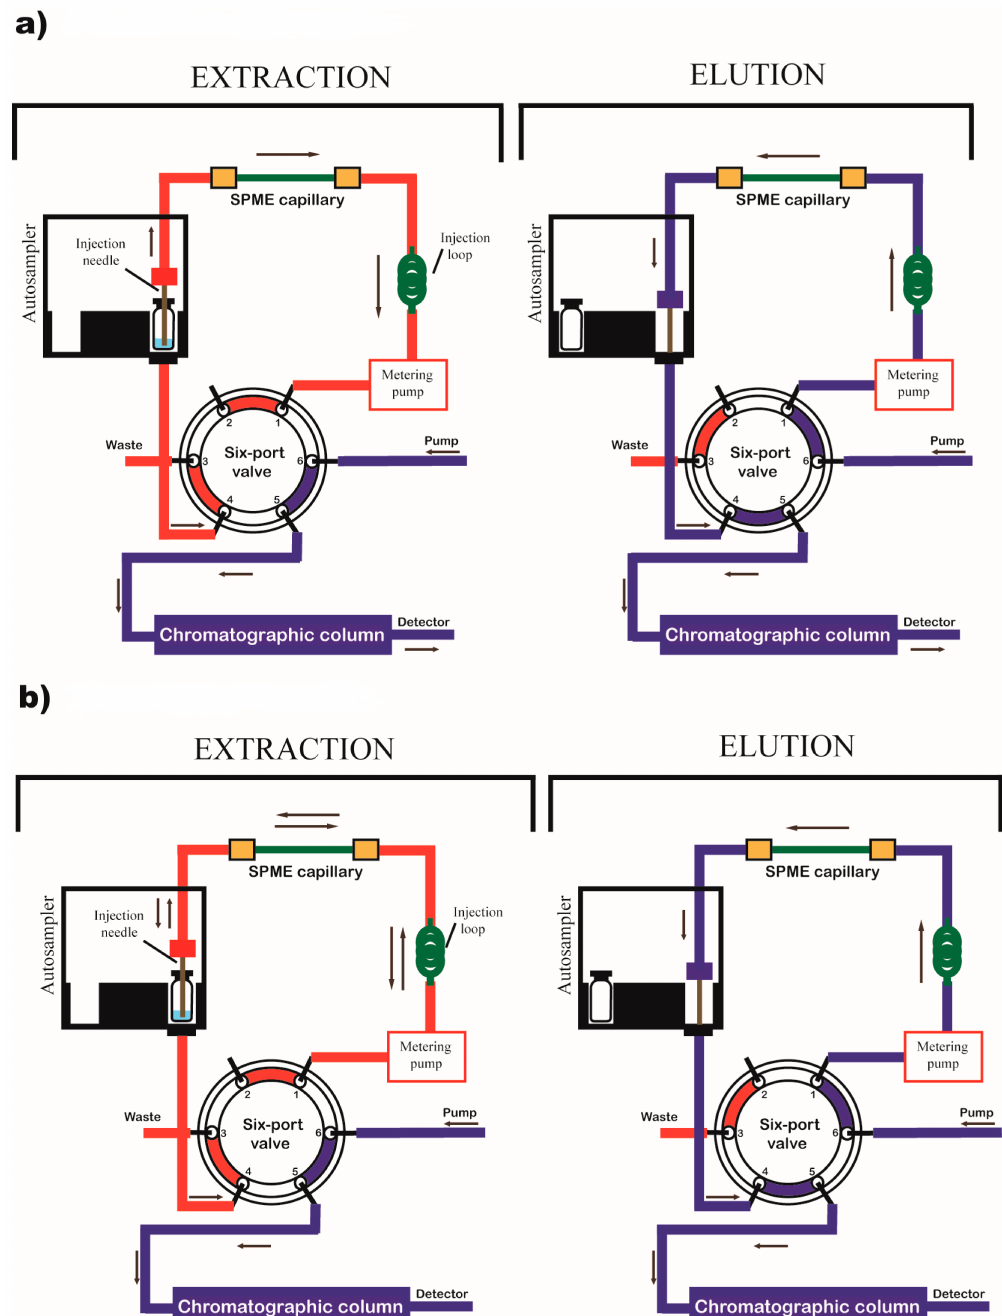
Figure 1. Graphic diagrams of in-tube SPME configurations. ( a ) Flow-through mode; ( b ) draw/eject mode adapted from reference